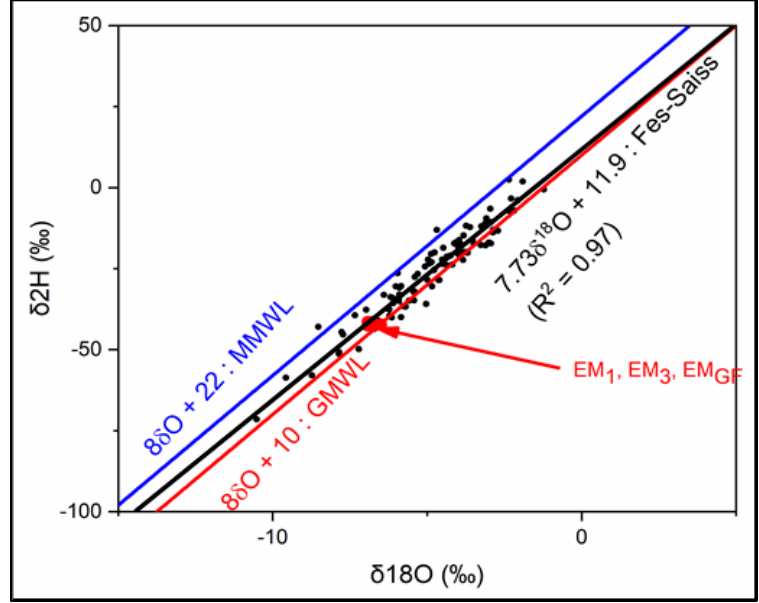
Figure 9. Local meteoric water line corresponding to the Middle Atlas (Fez-Saiss). The line of equation ( δ 2 H = 7.73 δ 18 O + 11.9; R 2 = 0.97) for the rains of Fez-Saiss in the Middle Atlas is different from the line relating to the rainwater in the Anti Atlas [54], ( δ 2 H = 8 δ 18 O + 14.5), in the High Atlas ( δ 2 H = 8 δ 18 O + 13.5) [55], and in central Morocco ( δ 2 H = 8 δ 18 O + 13.0) [56]. The data from the previous works come from short time series (2 years), which could be statistically biased with respect to the Fez-Saiss